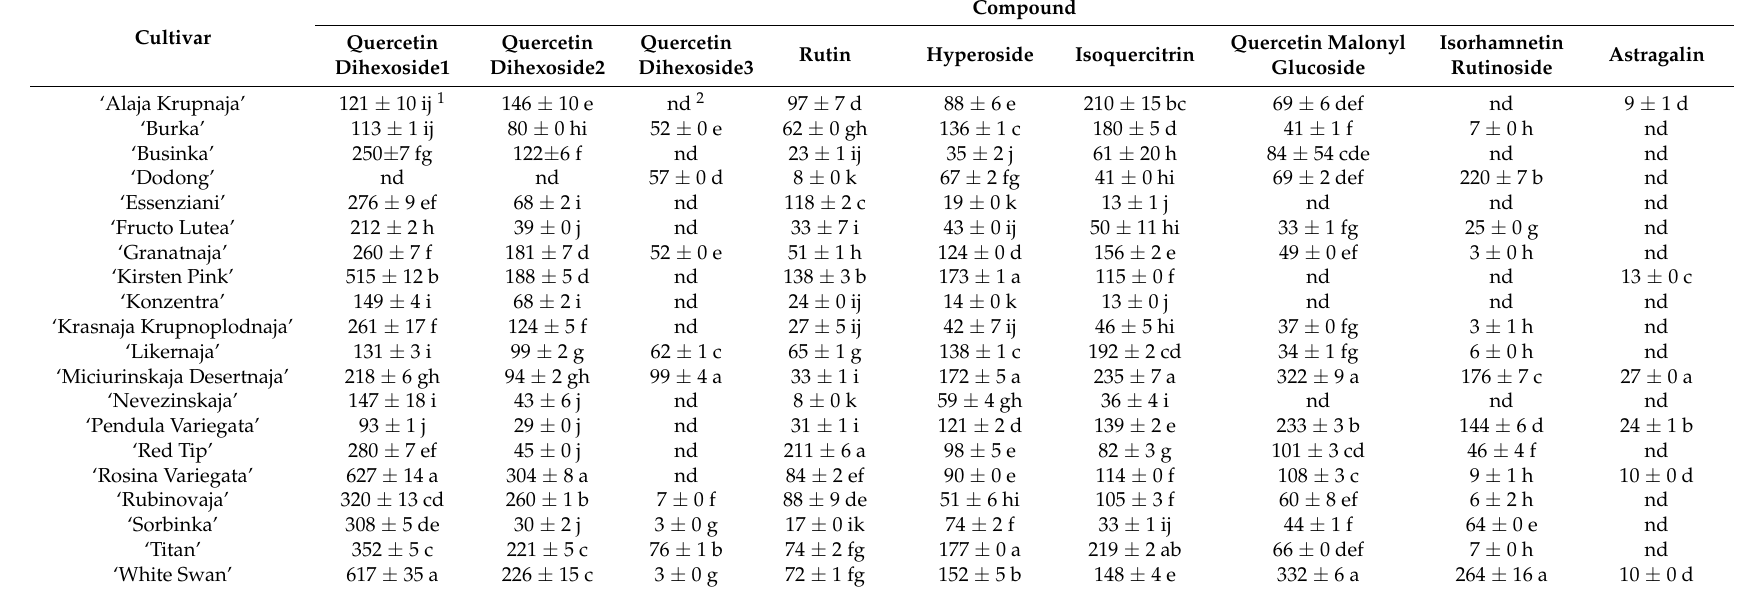
Table 2. Contents of flavonoids ( µ g/g DW) in Sorbus fruit powder